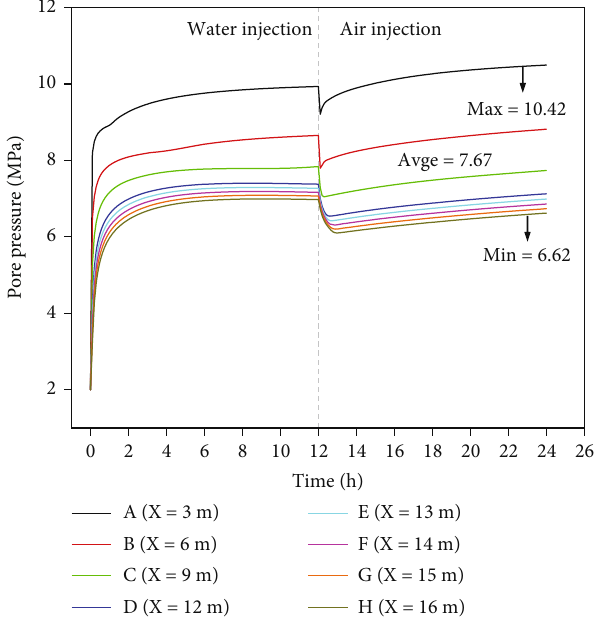
Figure 12: Time-dependent pore pressures at di ff erent detection points.